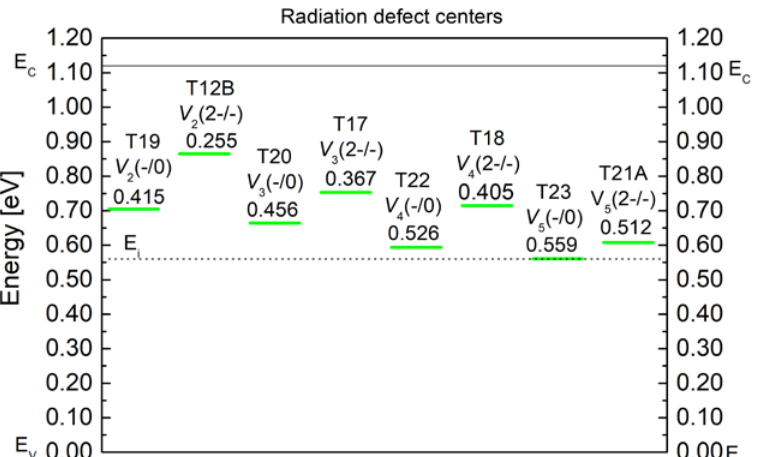
Figure 4. Positions of the T12B, T17, T18, and T21A traps attributed to the energy levels in the Si